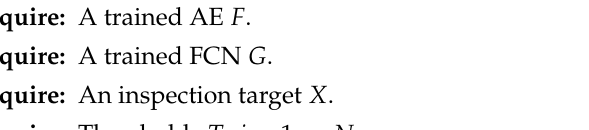
Algorithm 1 Proposed quality inspection of surfaces algorithm.